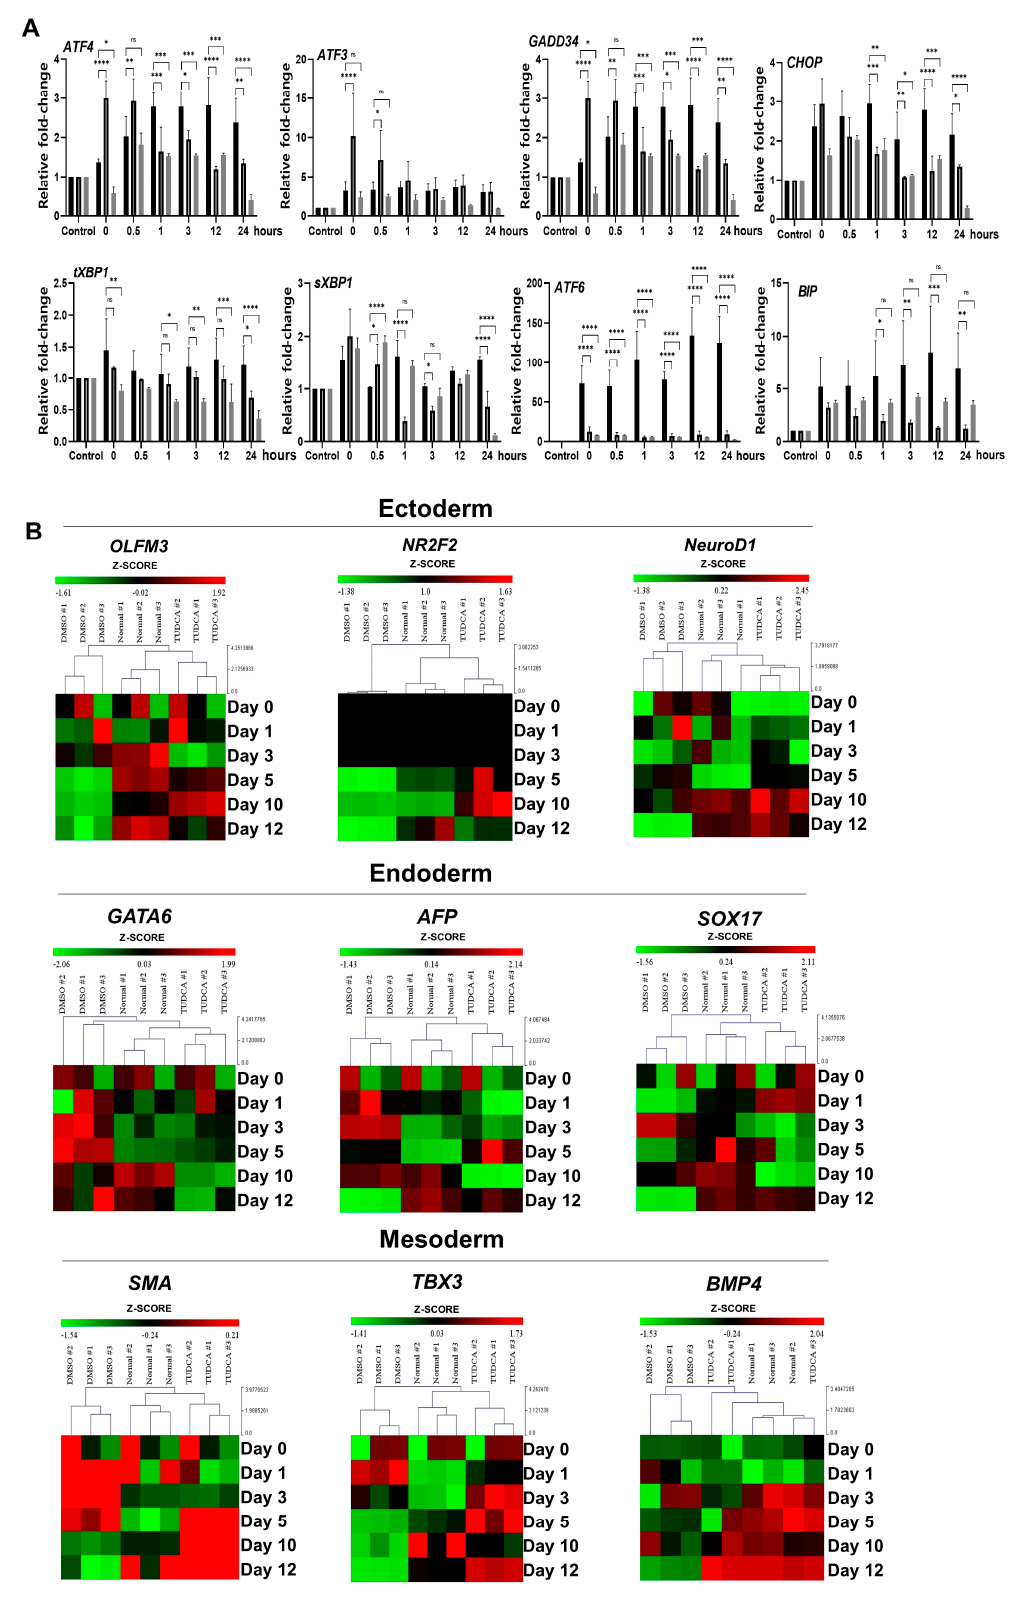
Figure 4. Tauroursodeoxycholic acid (TUDCA) suppressed the induction of UPR-related genes under heat stress. ( A ) UPR-related genes measured by RT-qPCR. Left: EBs were cultured under normal conditions for the indicated times; right: DMSO (control)- or TUDCA-treated EBs cultured under hyperthermic conditions for the indicated times. Fold changes shown are the mean values obtained